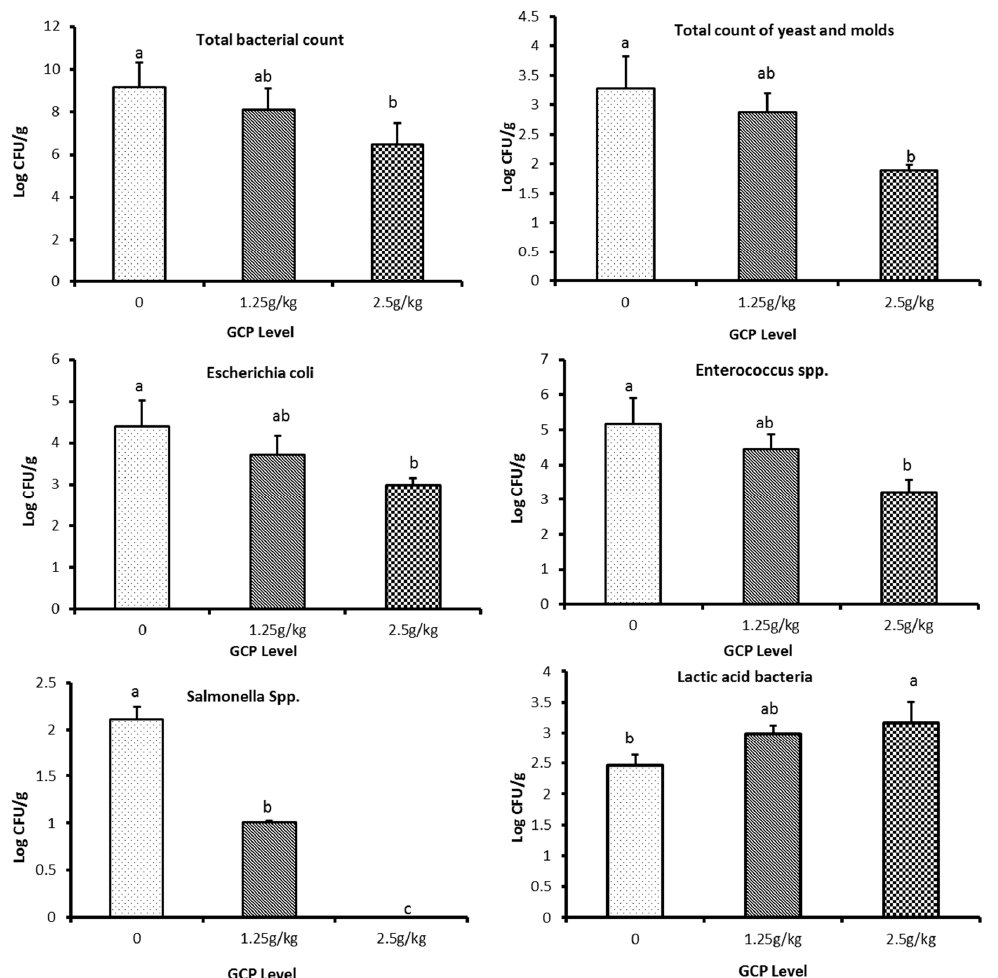
Figure 3. Effects of green coffee extract on ileal intestinal total bacterial count, total yeasts and molds count, Escherichia coli , Enterococcus spp., Salmonella spp., and lactic acid bacteria in growing broiler during feeding.